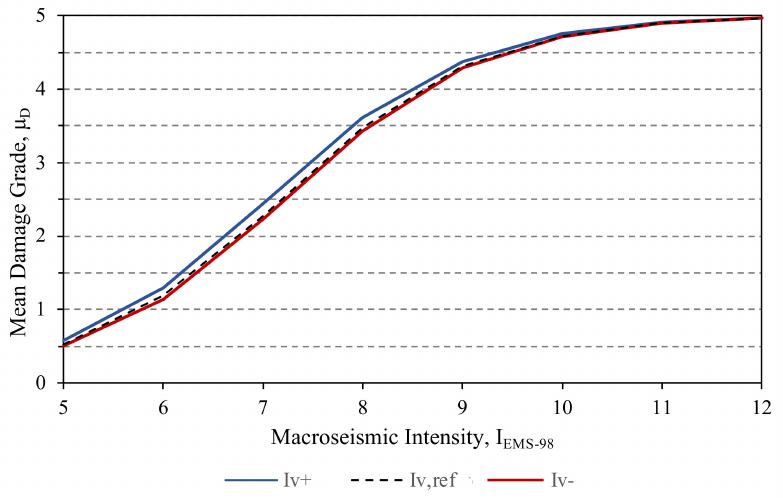
Figure 18. Vulnerability curves for the mean I + v = 47.90, I − v = 42.34, and I v,ref = 42.42. Minimum and maximum values are close to reference values, supporting the feasibility of the approach.